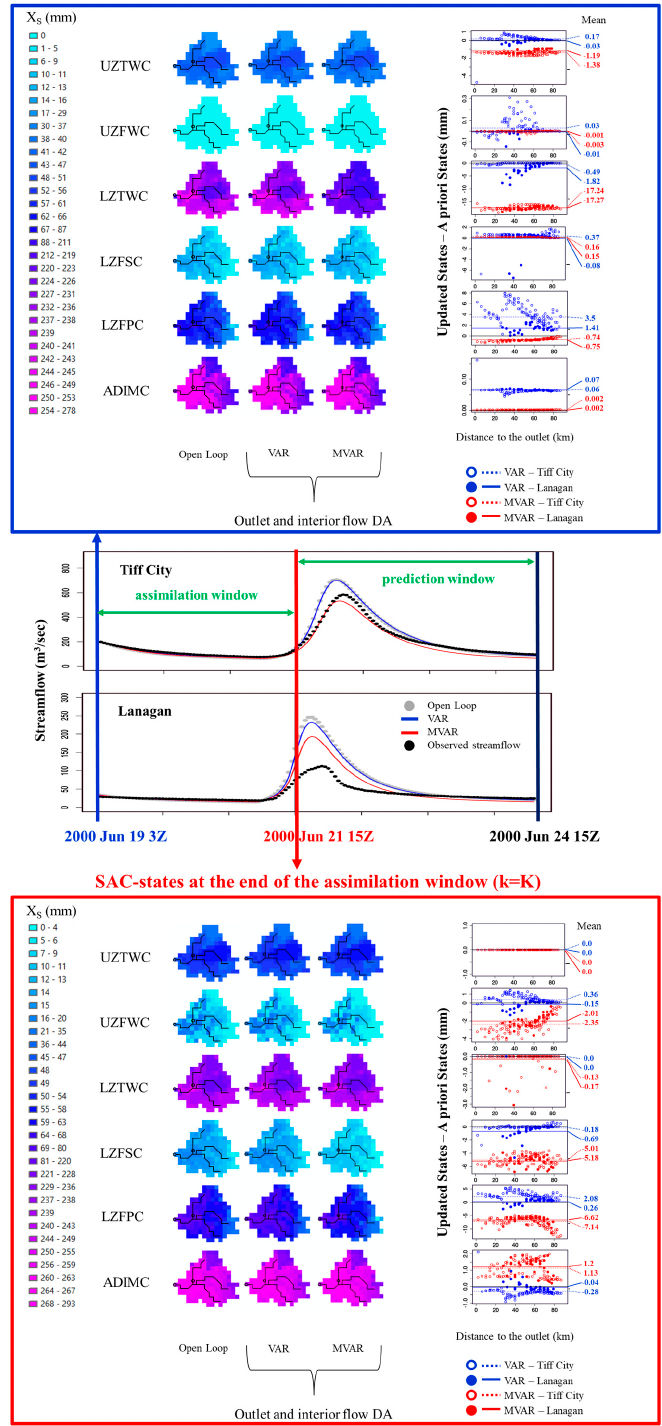
Figure 4. An example of comparing MVAR and conventional VAR results for a single assimilation cycle issued on June 21, 15Z, 2000. The sizes of assimilation and prediction windows used were 60 and 72 h. The model is applied as a strong-constraint to the assimilation problem and data assimilated includes outlet as well as interior flow observations. MFB estimates, or X B , j in Equation (1), are 0.9662, 1.0002, 0.9269, 1.0162, 0.9865, and 1.0 for UZTWC, UZFWC, LZTWC, LZSFC, LZPFC, and ADIMC,